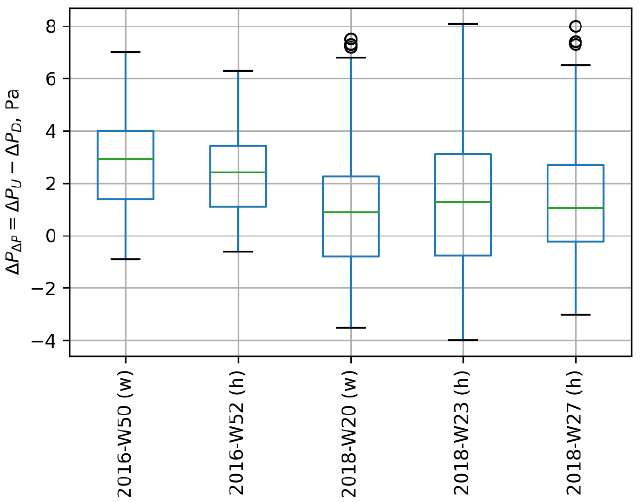
Figure 7. Difference in air pressure differences over the top and bottom parts of the wall. Each of the box-and-whiskers plots describe one week of data. (w) = work week, (h) = holiday week, (U) = upper part of the wall, (D) = lower part of the wall.